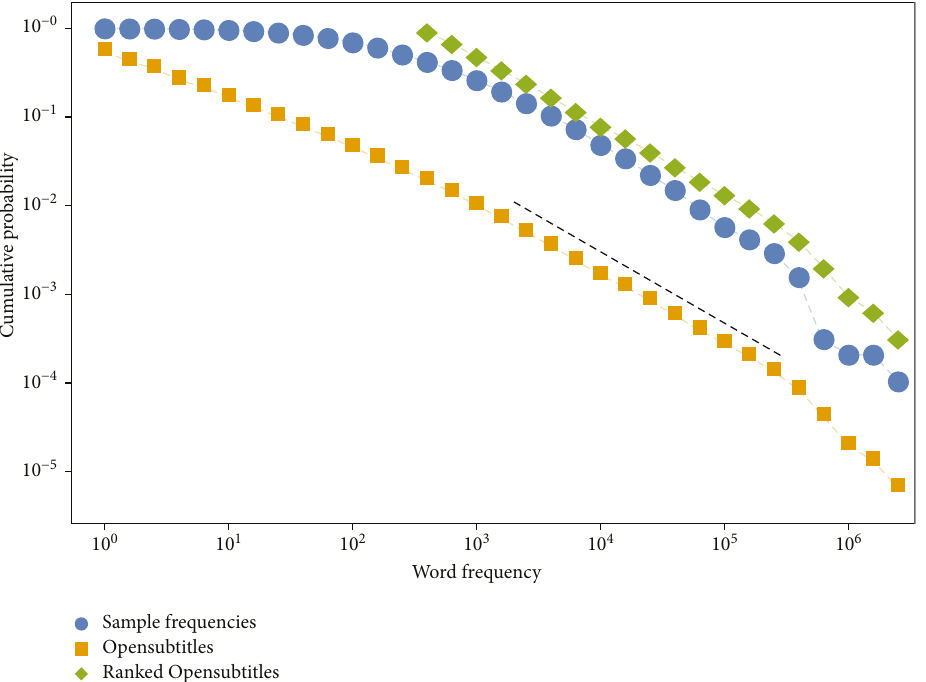
Figure 2: Cumulative probability distribution P ( X ≥ f ) of fi nding a word with frequency at least f in the multiplex lexical network with N =8531 words (blue dots), in the Opensubtitles dataset with 5 · 10 5 unique words (orange squares), and in the subset of N =8531 most frequent words from Opensubtitles (green diamonds). A power-law with exponent − 1 . 8 is reported for visual comparison (dashed